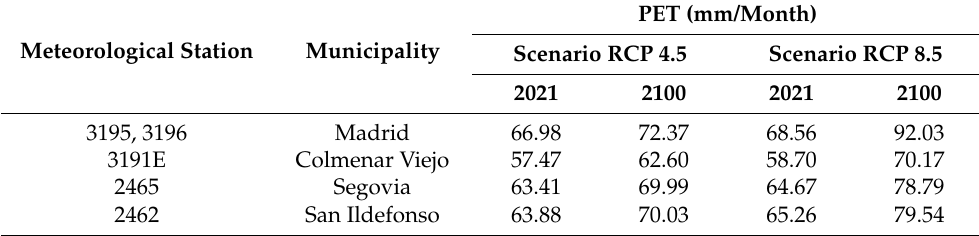
Table 6. Expected PET values for different climate change scenarios.